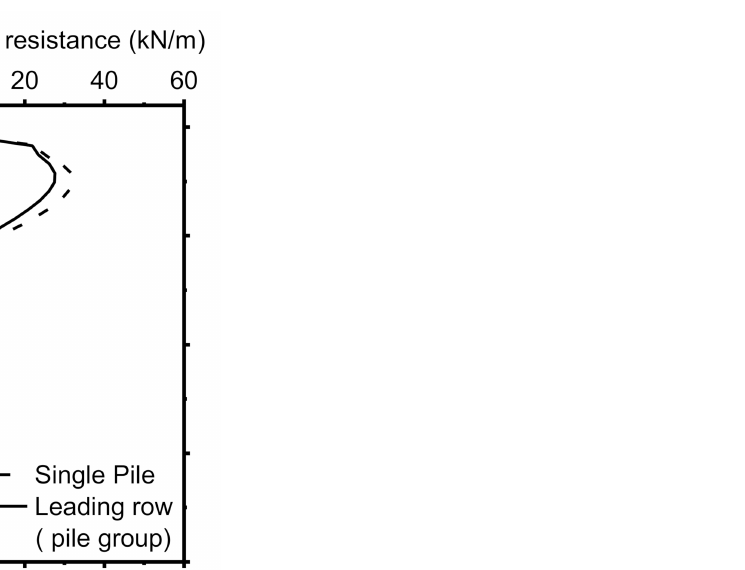
Figure 2. Average soil resistance for a single pile and leading row in a 3 × 3 free-head pile group at y = 50